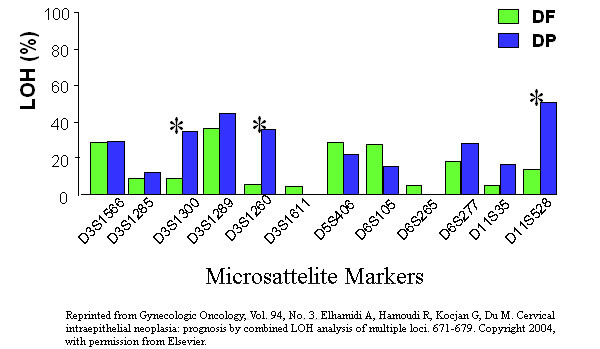
Example of output from LDMAS. LDMAS generated histogram showing the best set of LOH markers in cervical cancer highlighted by *. DF indicates Disease Free and DP indicates Disease Persistence/Progression CIN cases.